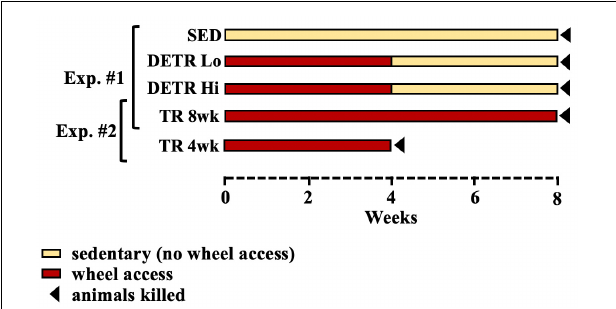
FIGURE 1 | Schematic representation of experimental design. In the first experiment (Exp. #1), sedentary (SED), detrained (DETR), and exercised-trained (TR 8wk) rats were compared over an 8-week period. DETR rats accessed resistance-free running wheels for 4 weeks before returning to SED conditions for an additional 4 weeks and were divided into low (DETR Lo) and high (DETR Hi) running distance groups. In the second experiment (Exp. #2), rats accessed wheels for 4 weeks (TR 4wk) and were sacrificed at the end of this period and independently compared to TR 8wk rats based on similar total running distances. Sedentary conditions for SED and DETR groups refer to normal cage activity associated with standard rodent housing (see section “Materials and